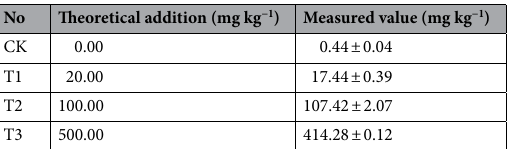
Table 1. The theoretical addition and actual concentration of Cd in the casing soil